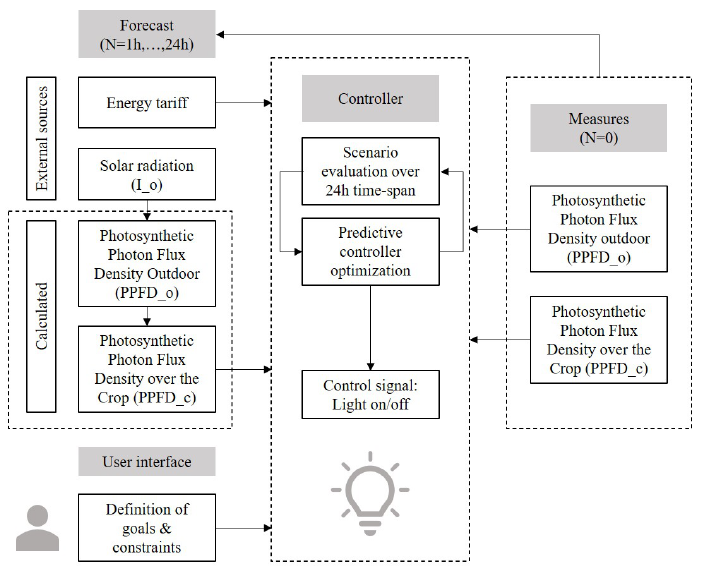
Figure 4. Framework of the variables used by the proposed control algorithm. The arrow connecting the measures box with the forecast one indicates that current monitored variables are used to tailor the prediction of their future